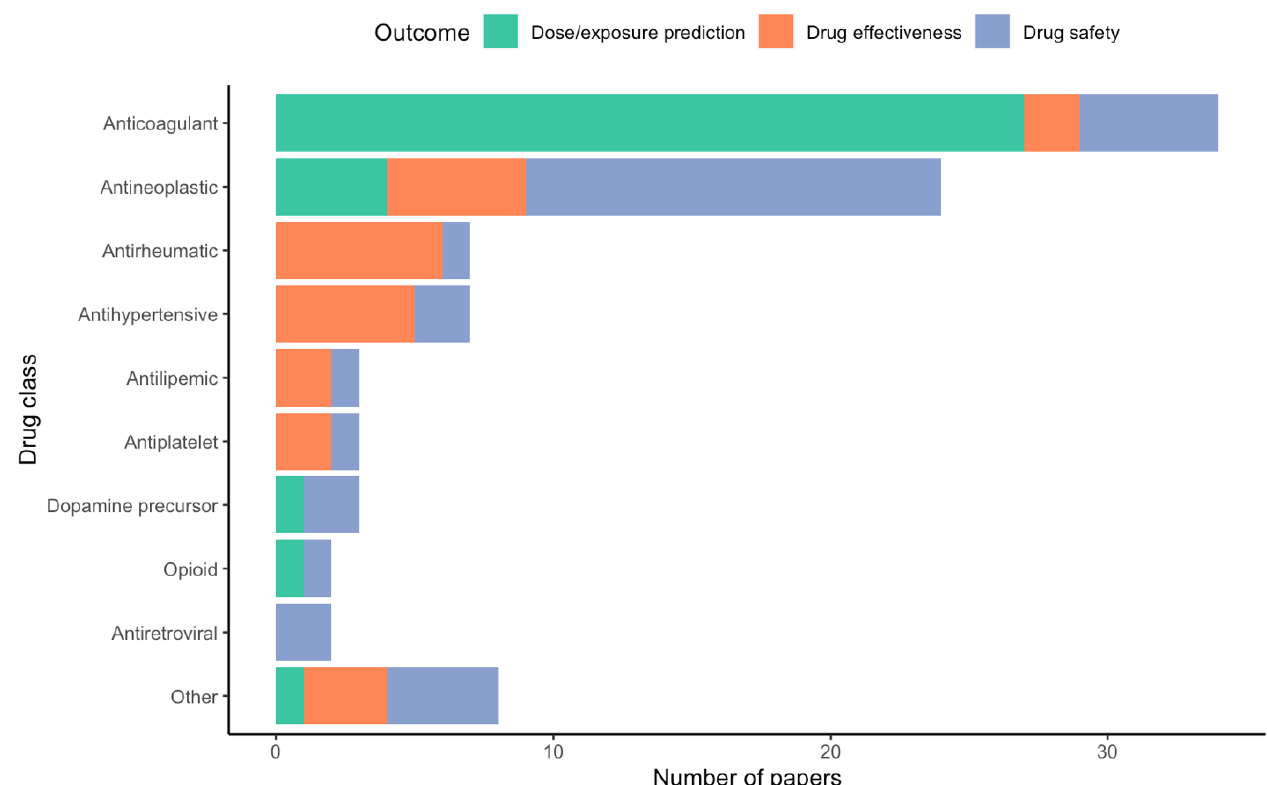
Figure 2. Number of articles included in the review grouped by drug class and investigated drug outcome. The “Other” category is comprised of Sufonylurea antidiabetic ( n = 1), Angiogenesis inhibitor ( n = 1), 5-Aminosalicylic acid derivative ( n = 1), Beta2 agonist ( n = 1), Antifungal agent ( n = 1), Antitubercular agent ( n = 1), Immunosuppressant agent ( n = 1), and Immune globulin ( n = 1).